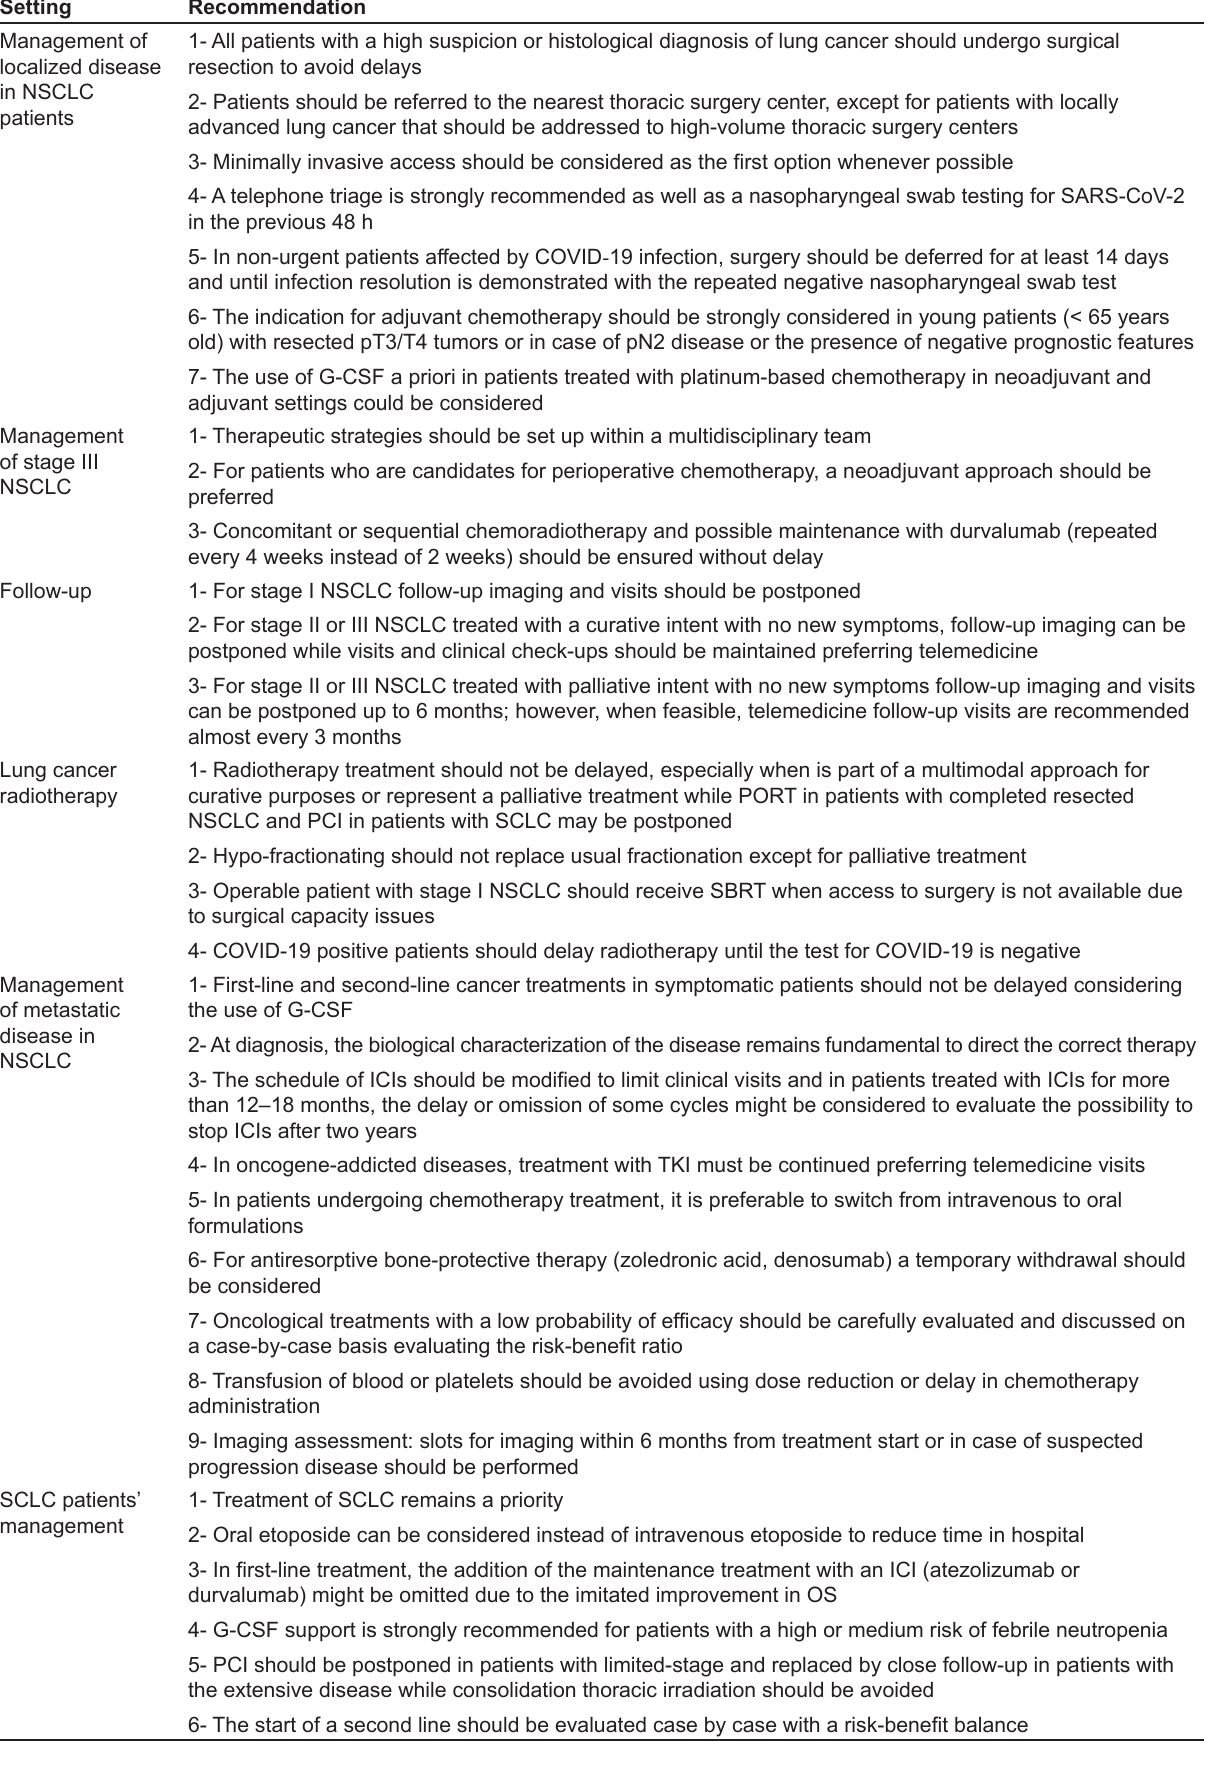
Table 1. The recommendation in lung cancer management ( continued )